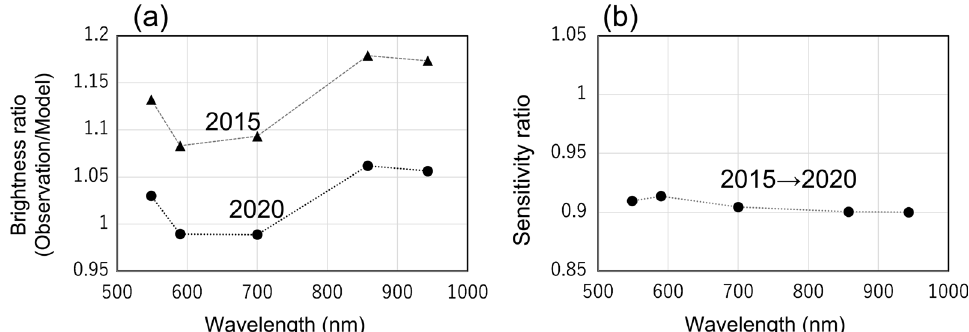
Fig. 11 a Ratios between the observed and modeled lunar brightness. The model brightness was estimated based on the SP model. b Sensitivity degradation between 2015 and 2020 for the lunar observations evaluated in ( a )